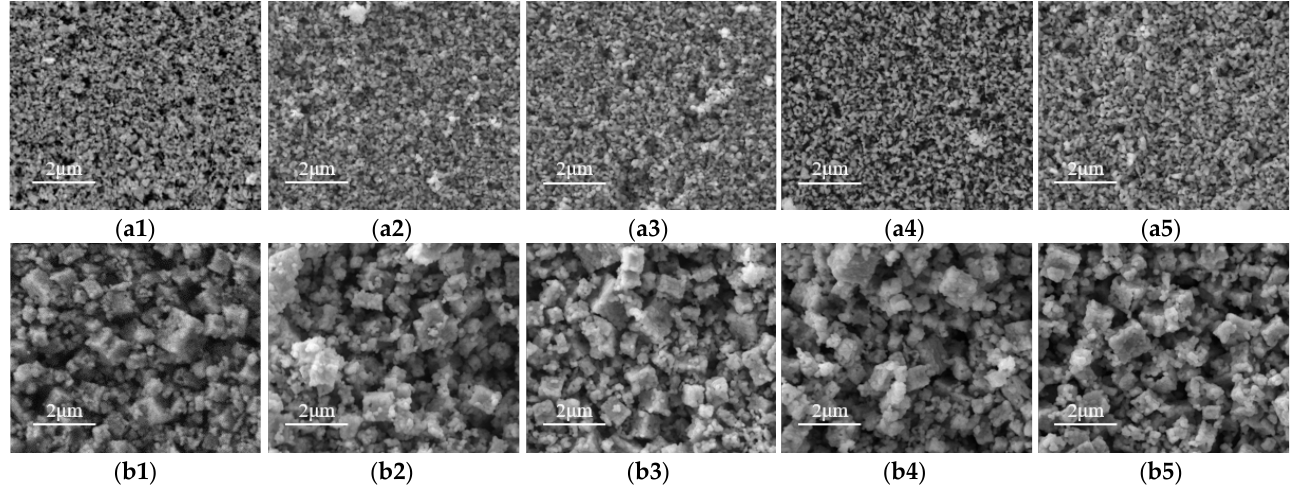
Figure 2. Surface morphology of the ITO (( a1 ) as-deposited; ( a2 ) 1 h; ( a3 ) 2 h; ( a4 ) 3 h; ( a5 ) 5 h), and In 2 O 3 (( b1 ): as-deposited; ( b2 ) 1 h; ( b3 ) 2 h; ( b4 ) 3 h; ( b5 ) 5 h) films annealed for different annealing times.